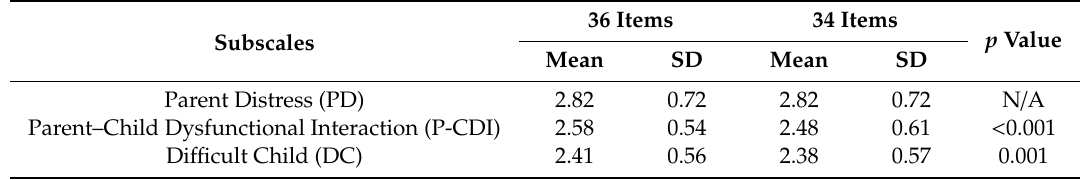
Table 7. Parenting stress level according to